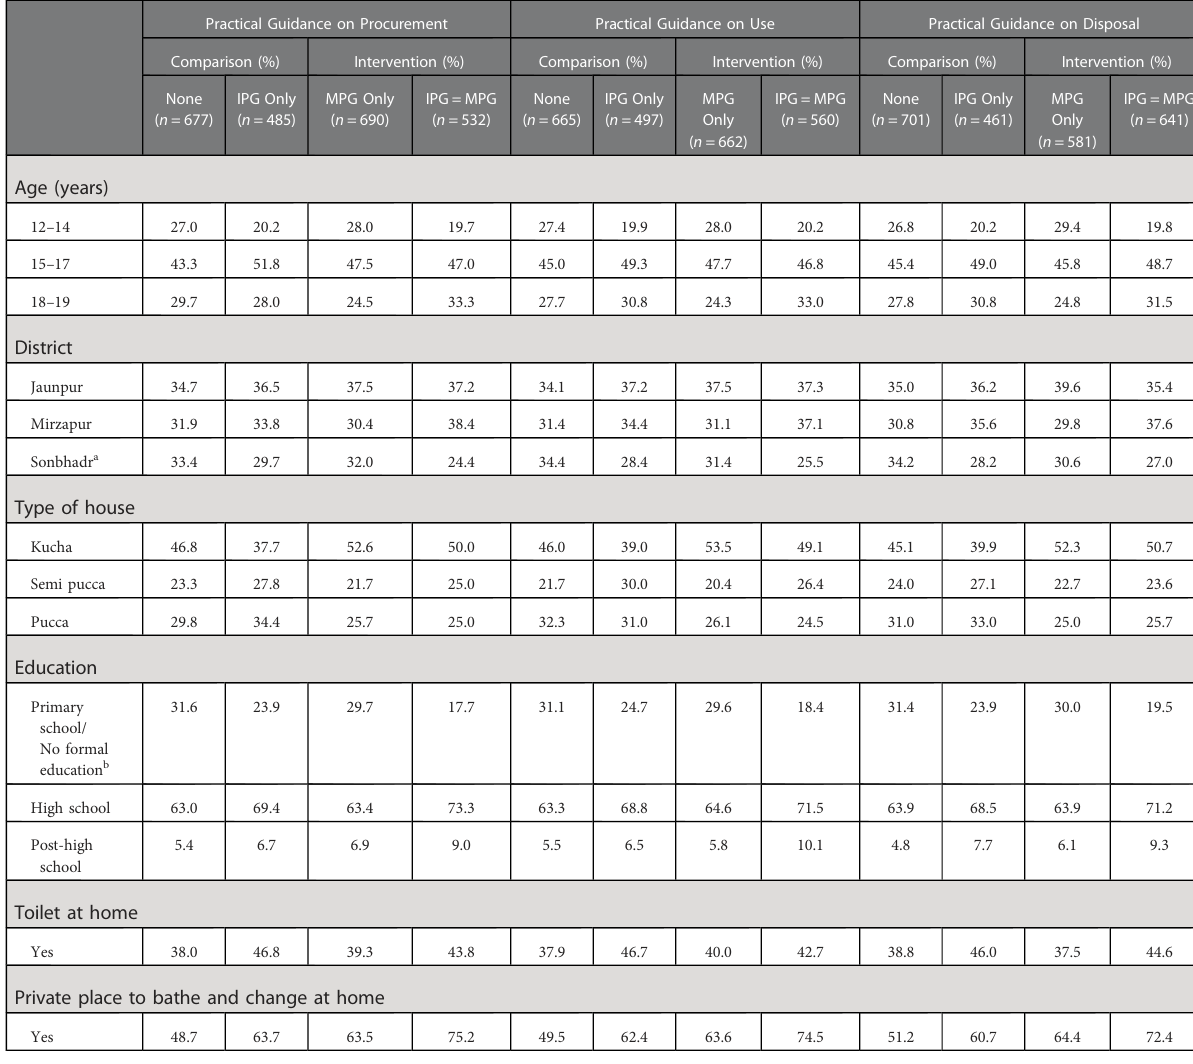
TABLE 3 Distribution of respondents by type of interpersonal and mediated practical guidance (IPG and MPG) received and background characteristics a